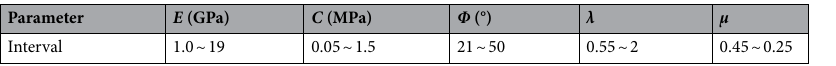
Measured horizontal convergence